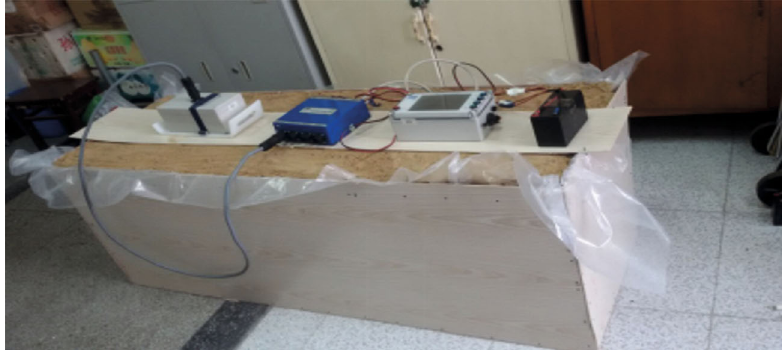
Figure 2: GV3-1 GHz radar test system and laboratory test platform.